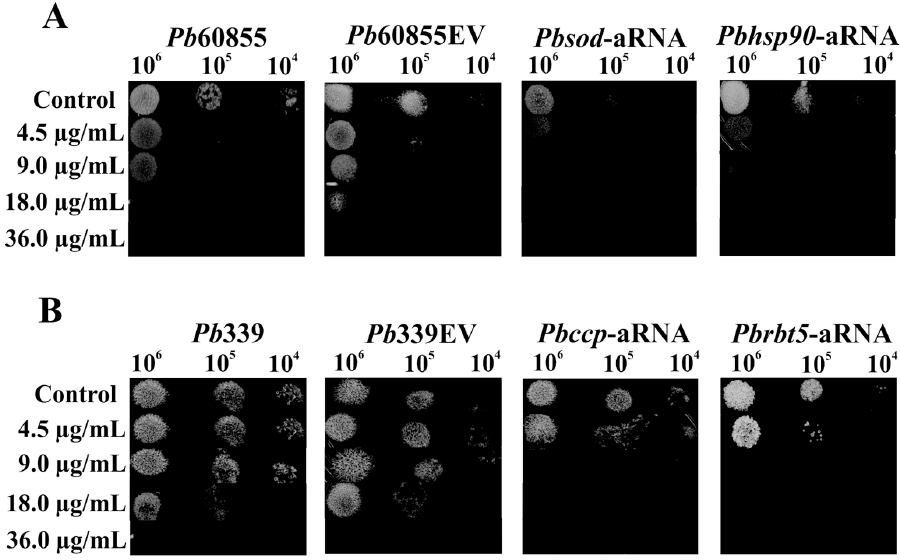
Fig 5. Susceptibility of Paracoccidioides brasiliensis yeast cells exposed to argentilactone. Samples containing 10 6 , 10 5 and 10 4 Pbsod -aRNA, Pbhsp90 -aRNA (A) , Pbccp -aRNA and Pbrbt5 -aRNA (B) yeast cells were spotted in solid Fava Netto ’ s supplemented with argentilactone at the concentrations of 4.5, 9, 18 and 36 μ g/mL. Control cells, wild type (WT) and empty vector (EV) were assayed without argentilactone. The plates were incubated for 7 days at 36°C before photo